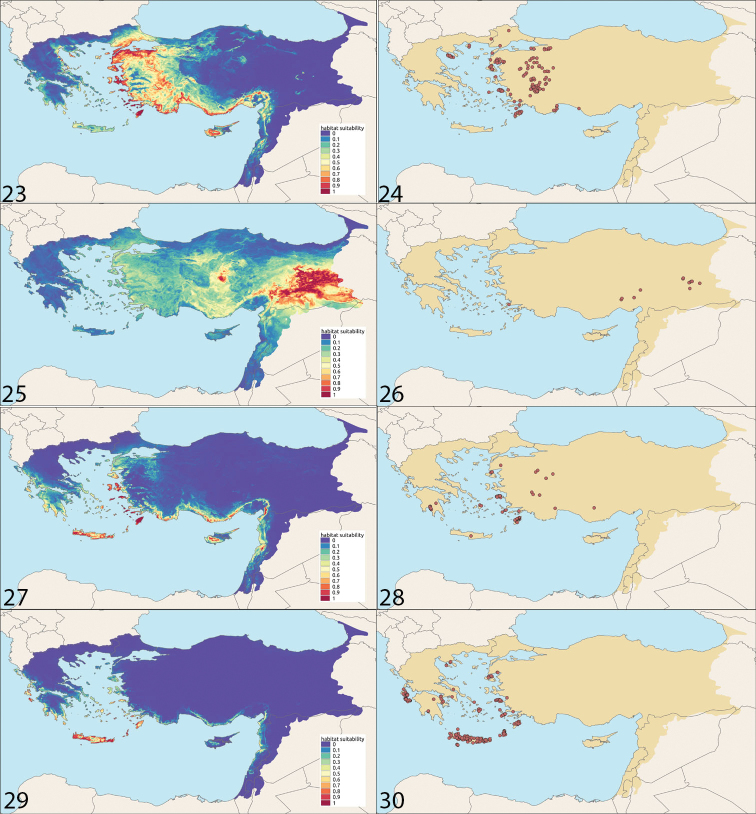
Habitat suitability and distribution 23, 24Camponotus
aegaeus25, 26Camponotus
aktaci27, 28Camponotus
boghossiani29, 30Camponotus
kiesenwettri.